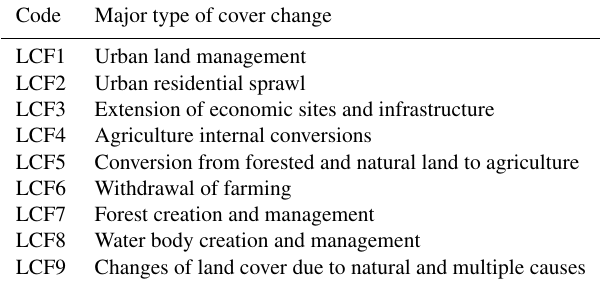
Table 1. Major land cover flows (LCFs) on Level 1 (EEA, 2013a).